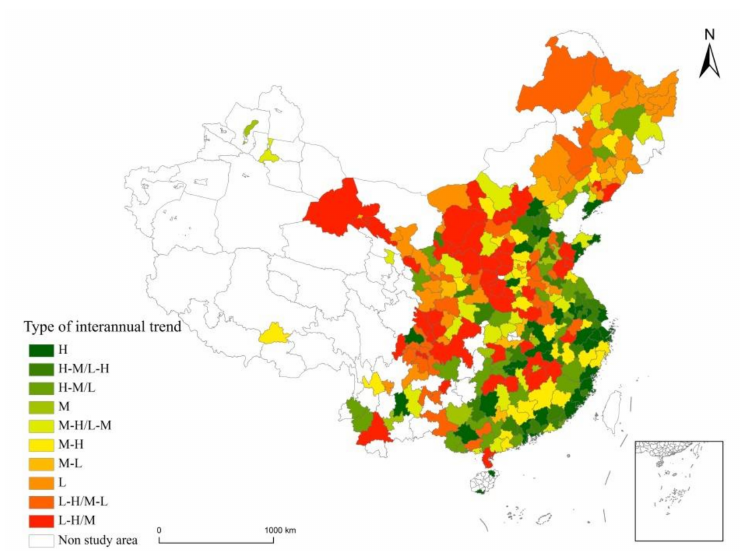
Figure 9. Spatial distribution map of the sustainable development model of urban human settlements in